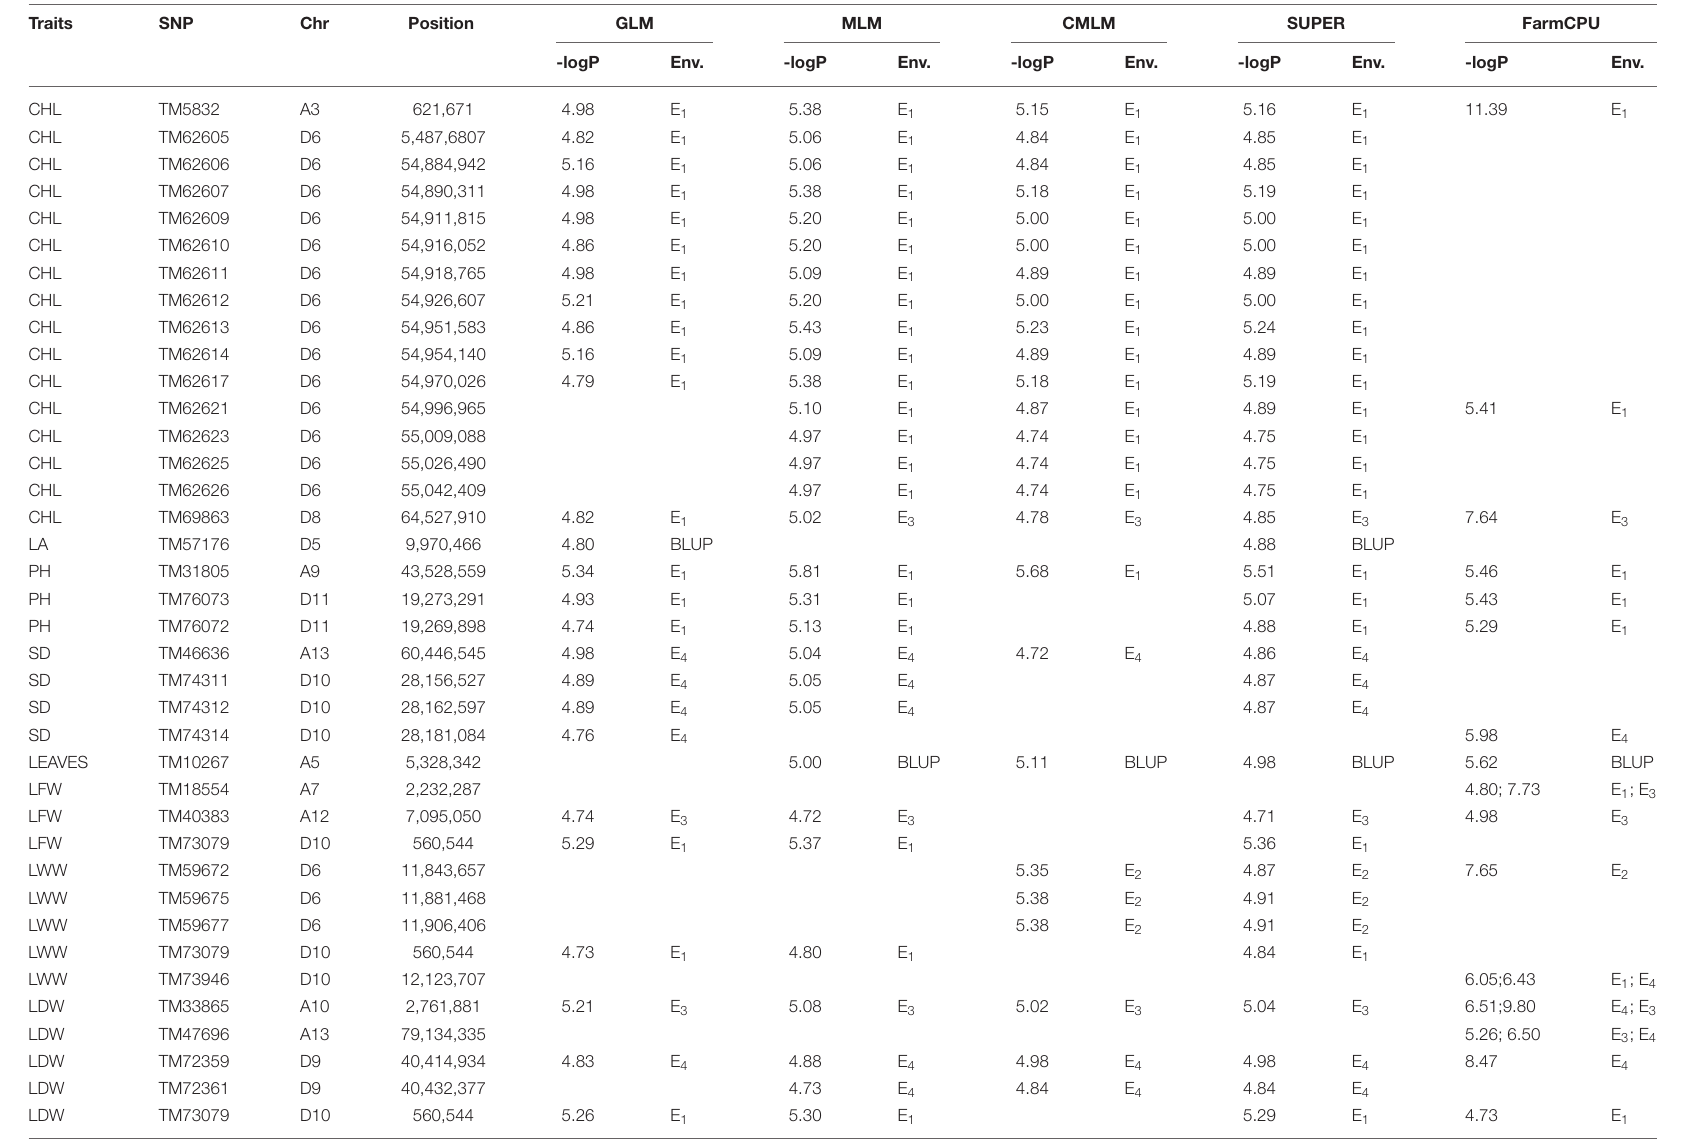
TABLE 3 | Significant SNPs associated with drought-tolerance traits that were repeatedly detected in at least two environments or two models.